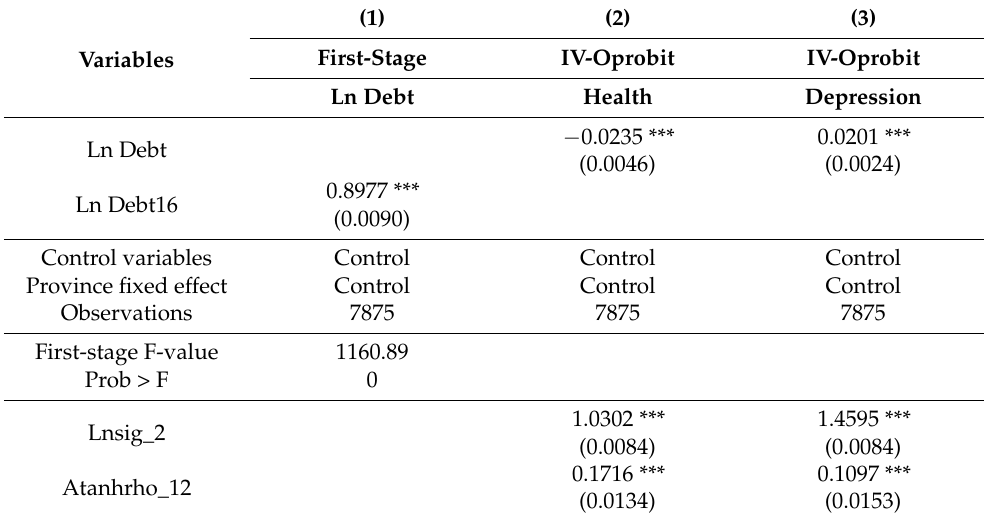
Table 5. Empirical estimation results of the IV-Oprobit